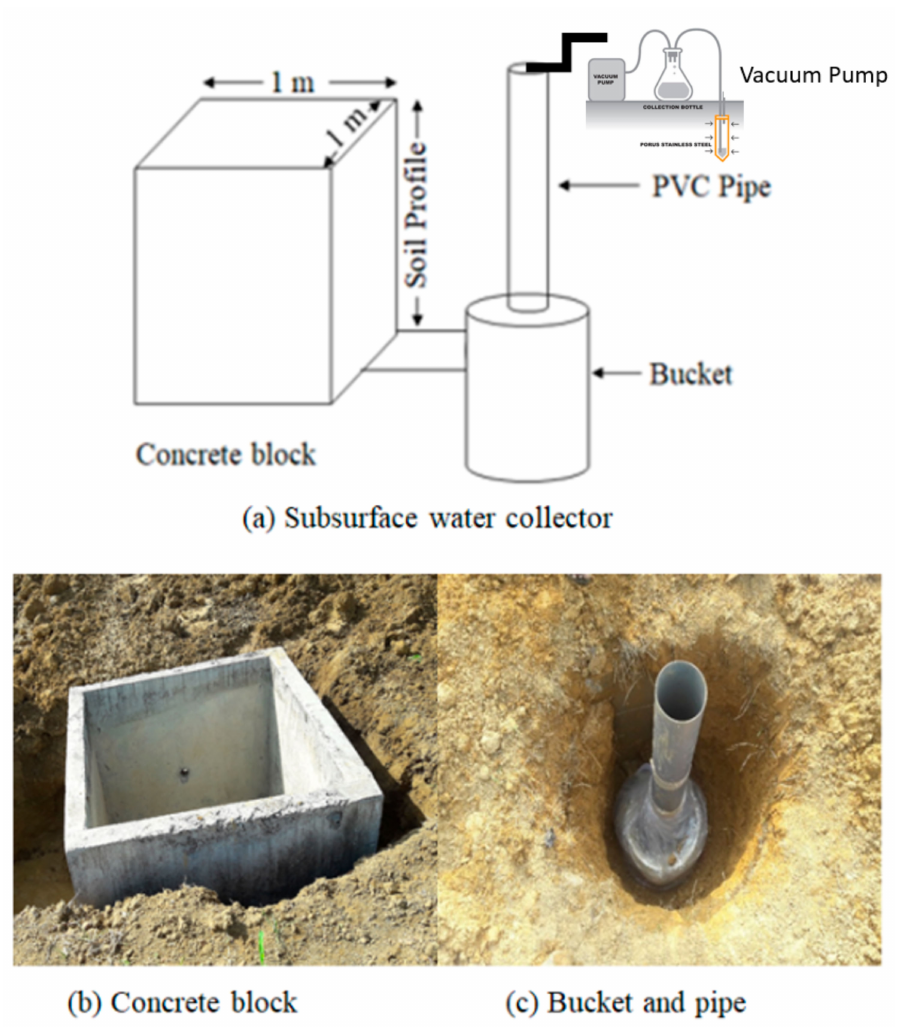
Figure 3. View of the sub-surface water collection system in the field